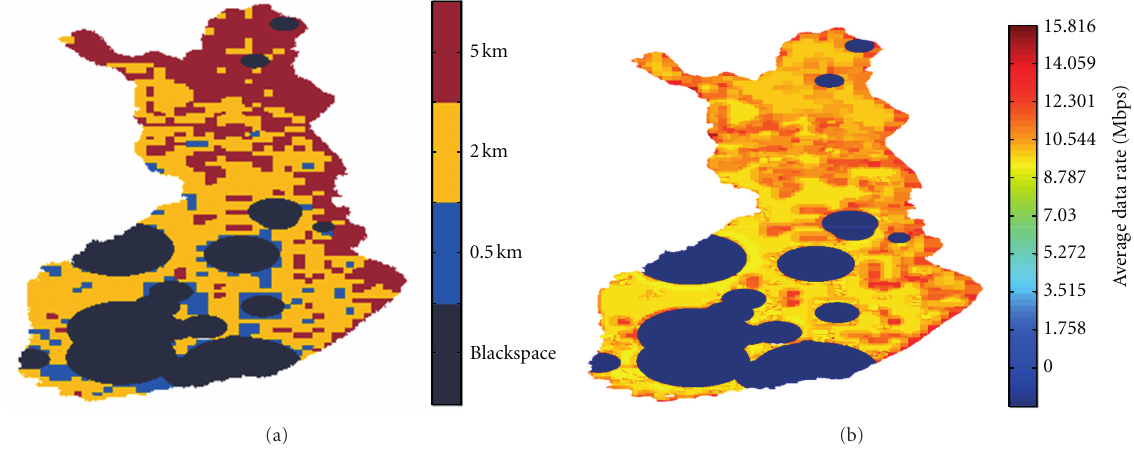
Figure 8: (a) Cellular layout in Finland based on the population density. The black space corresponds to the area where the secondary transmissions are not allowed. (b) Color-coded map of average data rate for a cellular network operating in TV channel 22 in